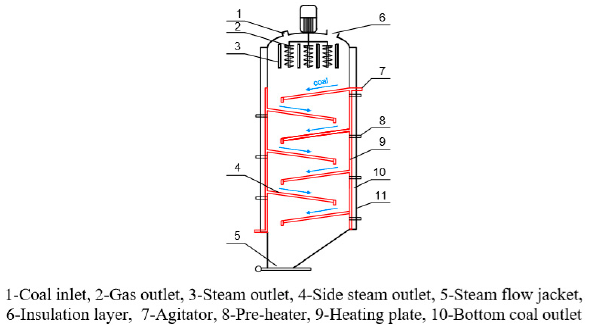
Figure 1. Structure diagram of a new type of a moving bed coal moisture control device.